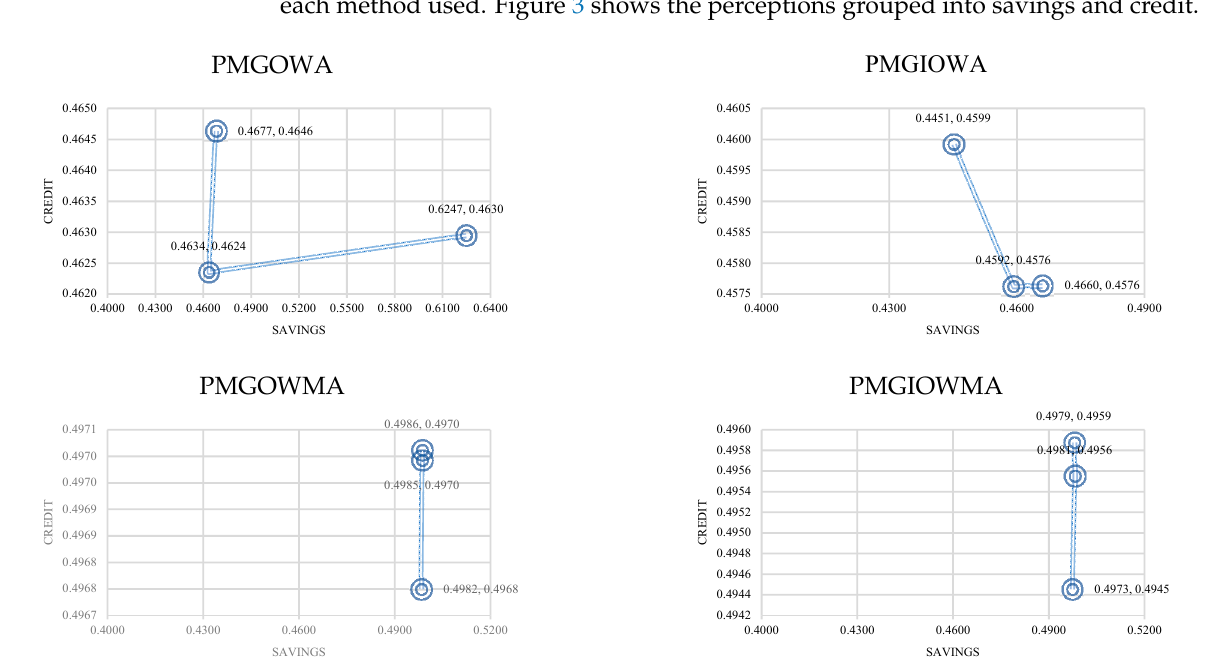
Figure 1. Perception relationships of savings and credit for each method. Based on the different graphs presented in Figure 1, it is possible to see that, with the PMGOWA operator, the relationship between credit and savings can change drastically from (0.4634, 0.4624) to (0.6247, 0.4630), but if a more complex operator is used, such as the PMGIOWMA operator the changes are not that important and are between (0.4973, 0.4945) and (0.4979, 0.4959). Finally, as a conclusion and considering all the results ob- tained by the operators, the relationships between the perceptions are 0.4500–0.500 and 0.4500–0.5000; higher results than these are seldom seen.